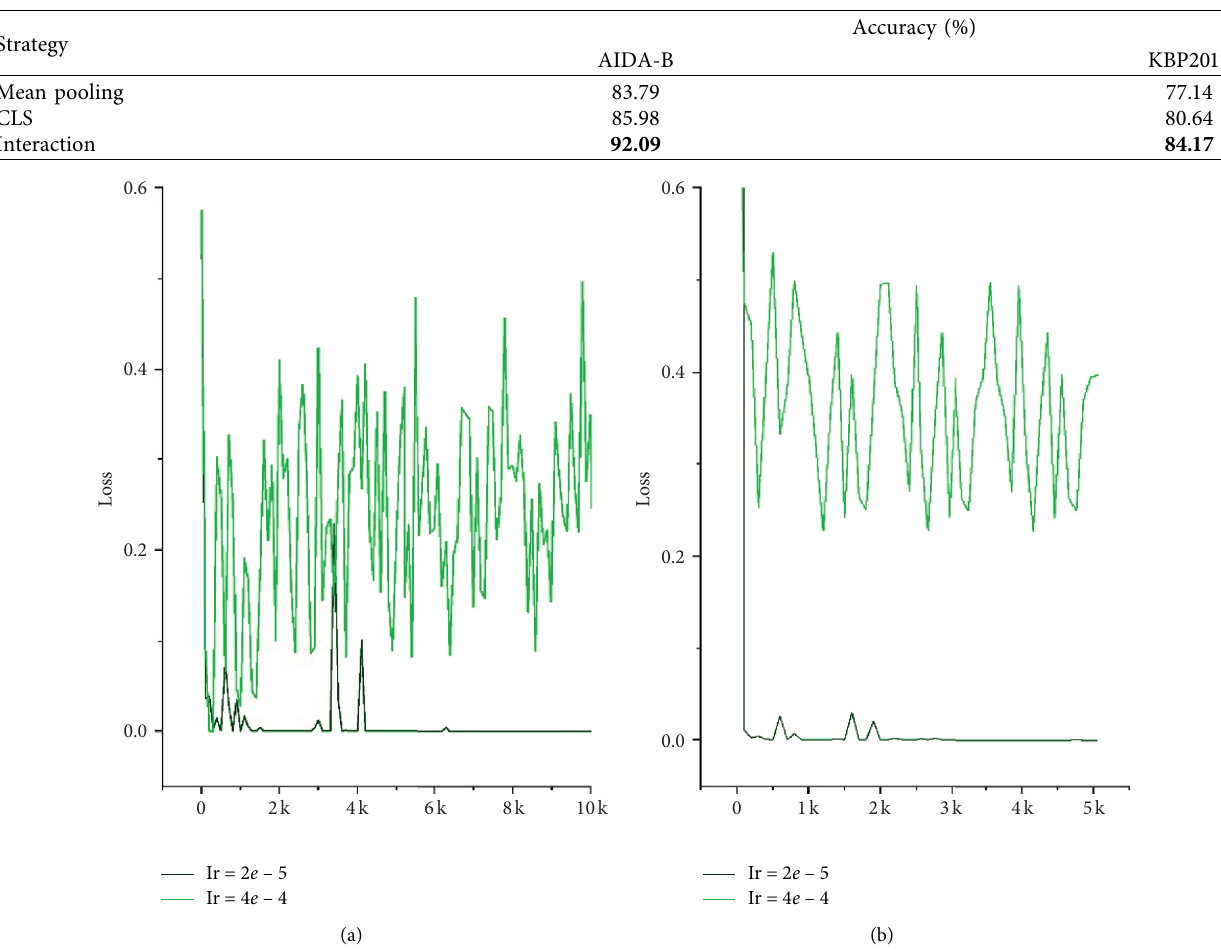
Table 4: The accuracy results based on different sentence representation strategies.